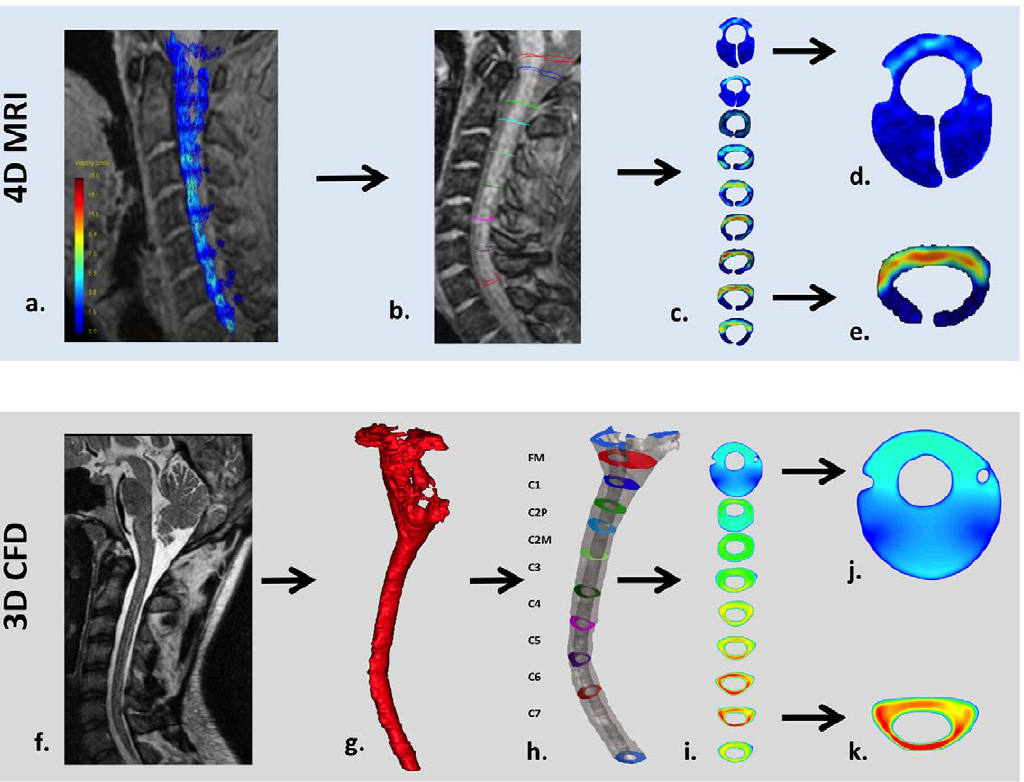
Figure 3. Workflow for 4D PC MRI (top row) and CFD (bottom) methodology in a healthy volunteer. a) 4D PC MRI velocity vectors superimposed on the coarse 2D anatomy scan. b) Placement of axial planes along the cervical SSS and c) 2D velocity profile visualization of the axial planes. d) Velocity profile example at the FM where ROI image truncation was required due to low velocities and noise in the MRI signal (see Methods for details). e) Velocity profile in the lower cervical SSS where the ROI required less image truncation. f) High resolution anatomical MRI scan used to define the geometry for the CFD simulation. g) 3D rendering of the cervical SSS segmentation before end truncation and geometric smoothing. h) 3D rendering of the smoothed cervical SSS geometry and axial planes where the CFD velocity profiles were observed. i) 2D velocity profile plots for each axial location. j) Velocity profile at the FM showing a larger cross-section than the FM in the 4D PC MRI (compare to d). k) Velocity profile in the lower cervical SSS that compares more favorably in terms of ROI size and shape to that observed in the 4D PC MRI